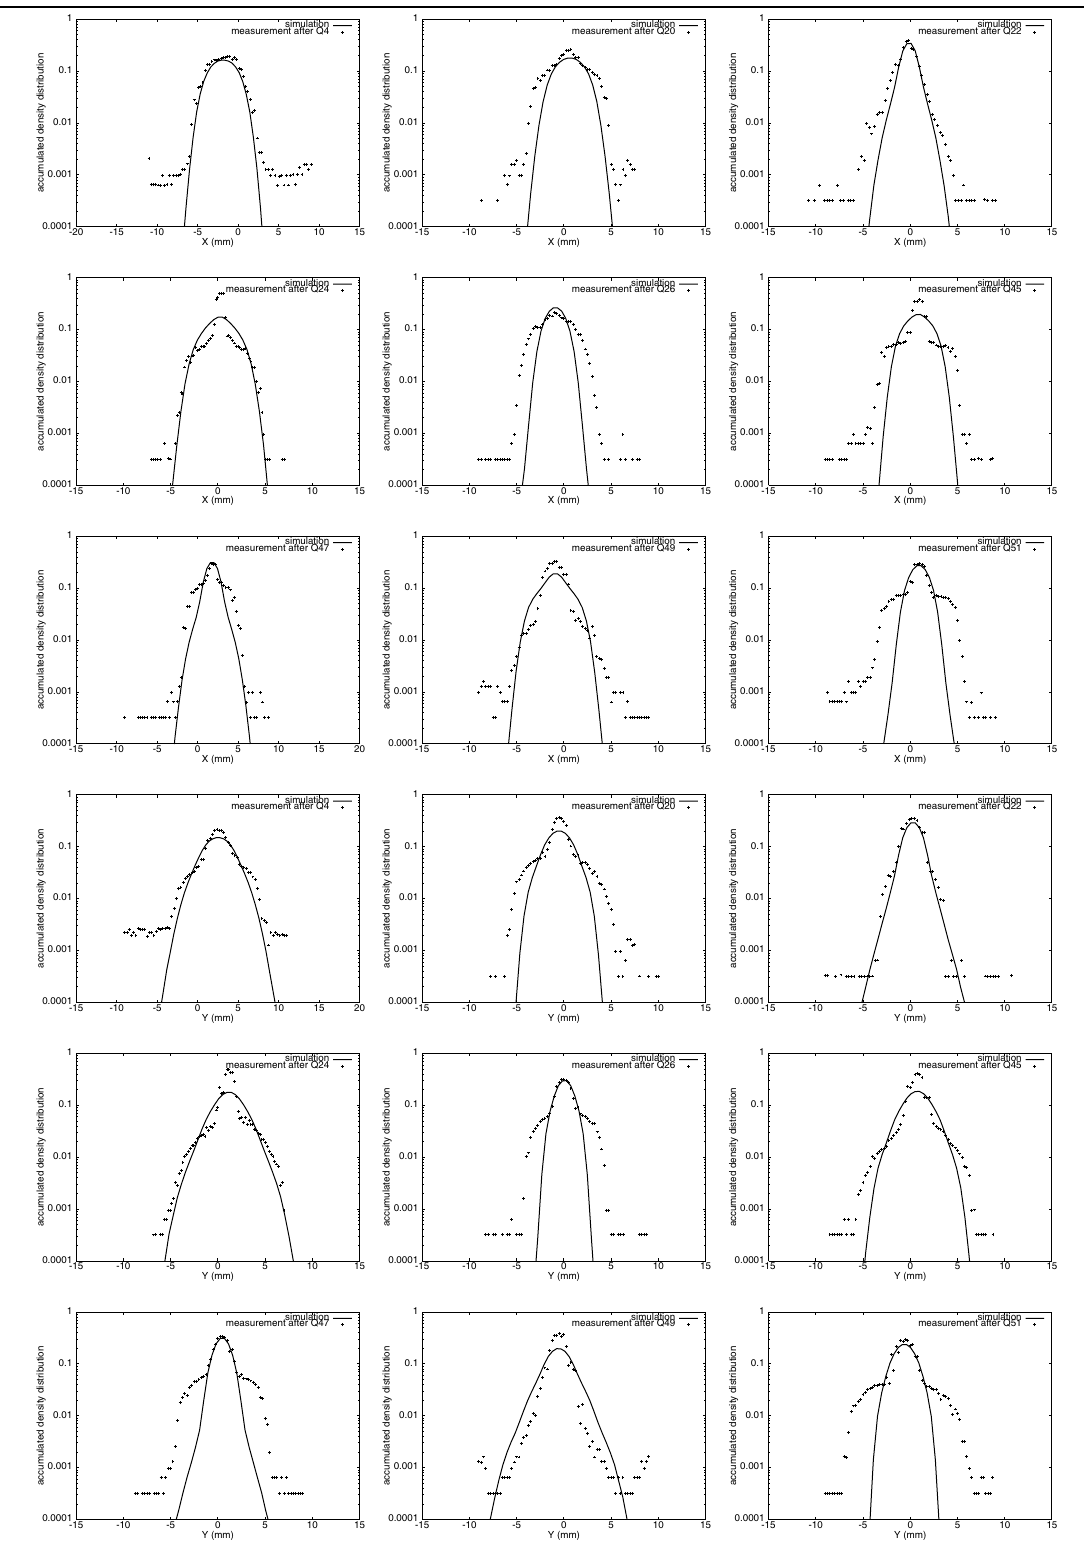
FIG. 8. X and y density distribution from simulation using initial Gaussian distribution and from measurements at 75 mA and mismatch factor of 1.5. The first nine plots correspond to the nine x profiles and the second nine plots correspond to the nine y